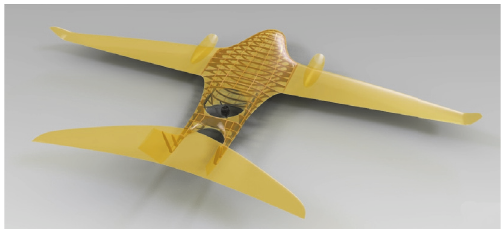
Figure 1: The initial concept of the VTOL